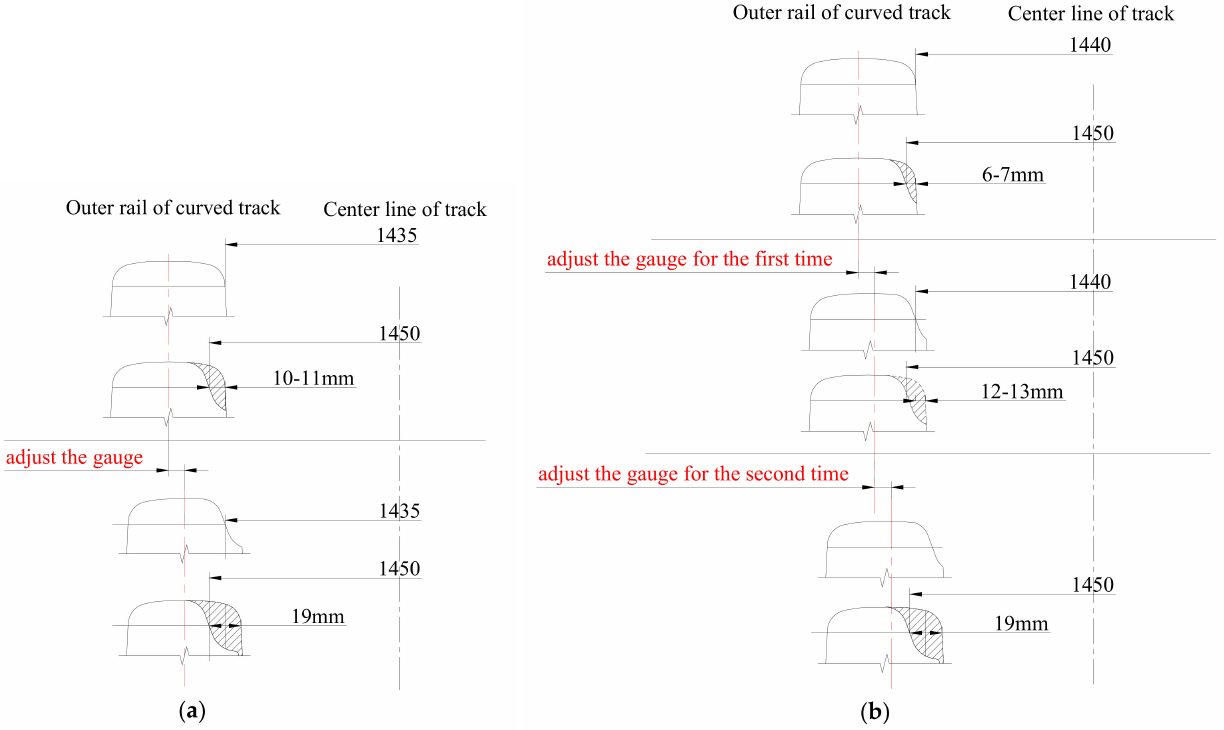
Figure 18. The influence of gage widening on track maintenance and repair. ( a ) Current gage widening standards; ( b ) the original gage widening